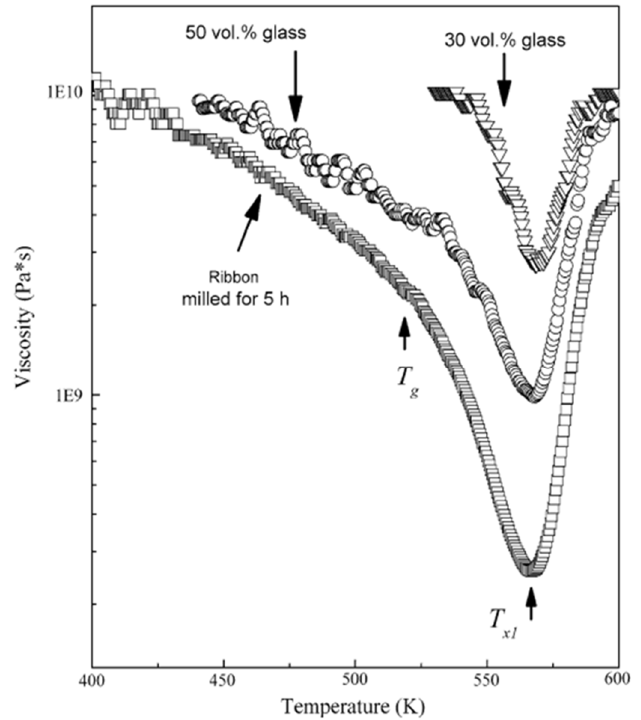
Figure 6. Temperature dependence (heating rate 10 K min − 1 ) of the viscosity of the supercooled liquid for the single-phase Al 85 Y 8 Ni 5 Co 2 glassy ribbon (mechanically milled) and for the Al matrix composites with 50 vol.% and 30 vol.% glass reinforcement. Reprinted from [45], Copyright (2008), with permission from Springer Nature.